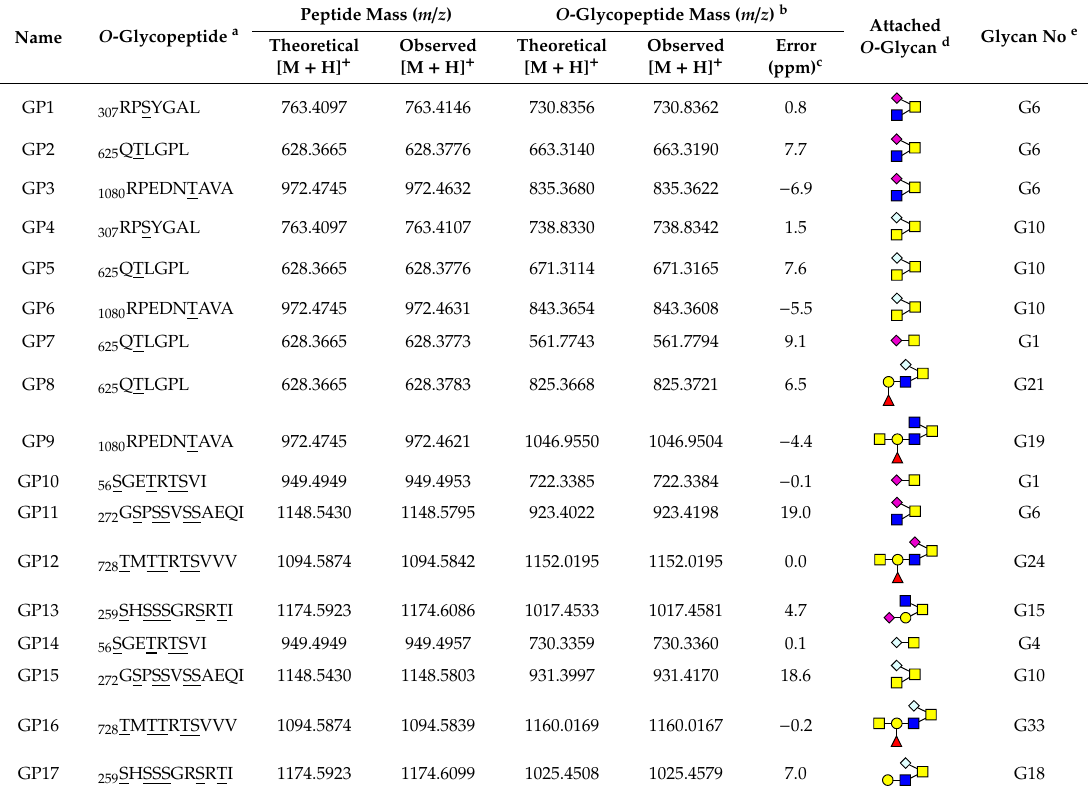
Table 2. Summary of O -glycopeptides, O -glycosylation sites, and attached O -glycans identified from proteinase K-digested BSM.